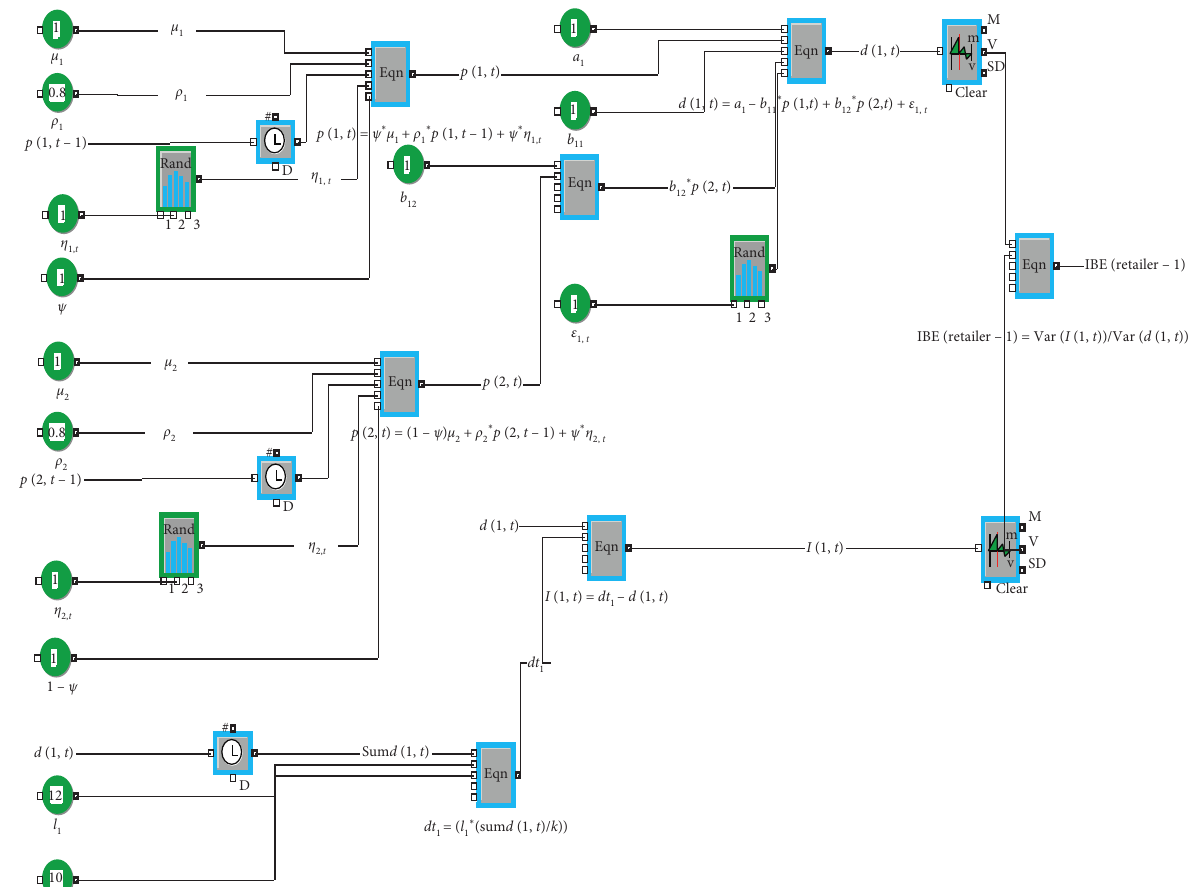
Figure 5: The simulation model of the inventory bullwhip effect based on the MA